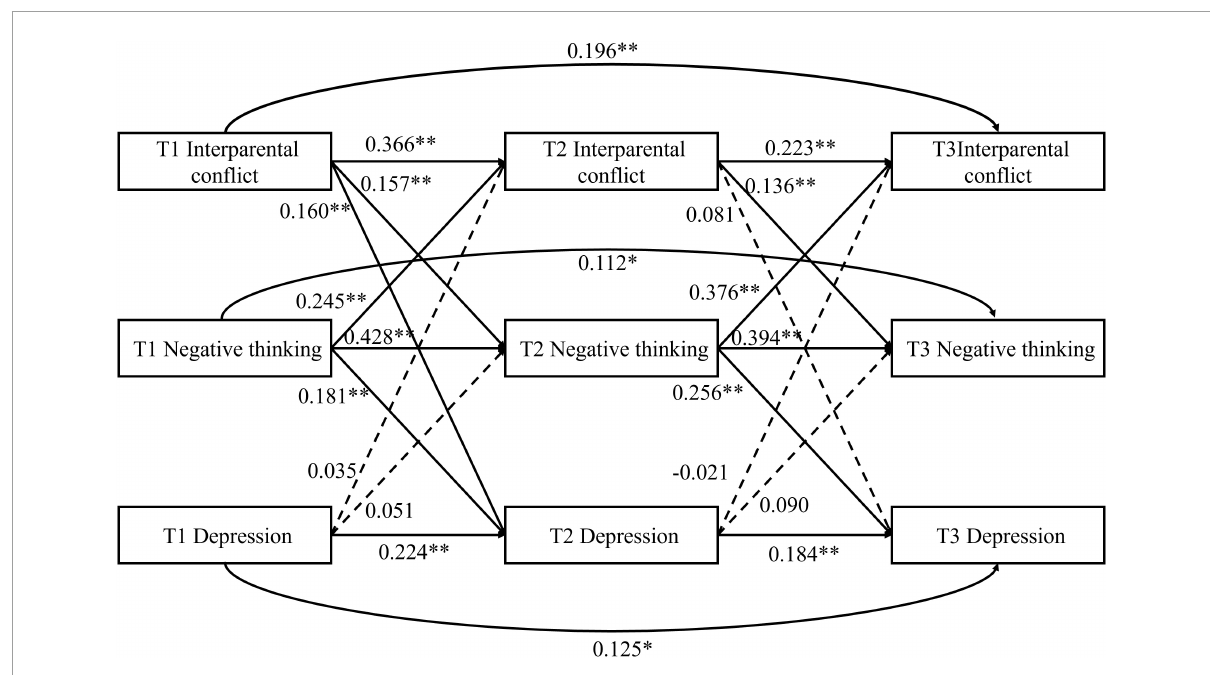
FIGURE2 Cross-lagged model of Chinese children’s perception of interparental conflict, negative thinking (NT) and depression. ∗ p < 0.05; ∗∗ p < 0.01.